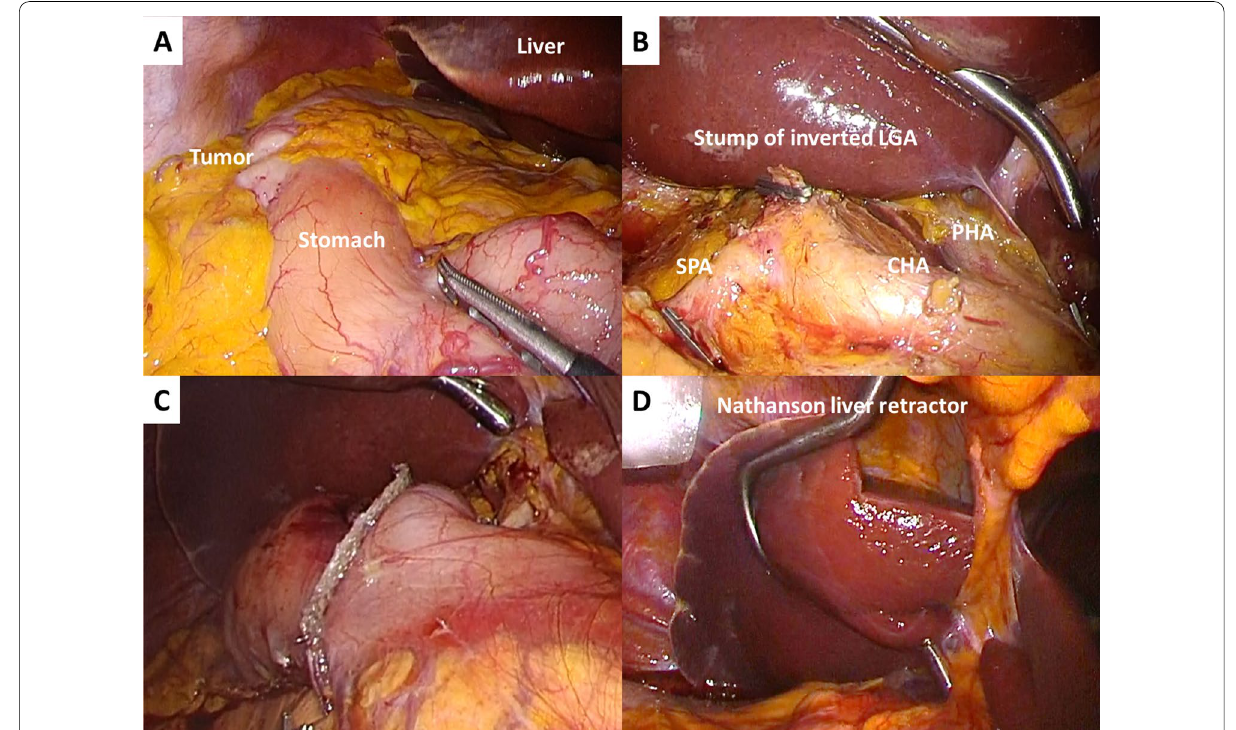
Fig. 3 A Abdominal organs were completely left–right inverted. B Intraoperative findings after D2 LND. C Intraoperative findings after modified delta-shaped Billroth-I reconstruction. D Findings of retracting the lateral segment of the liver with the Nathanson liver